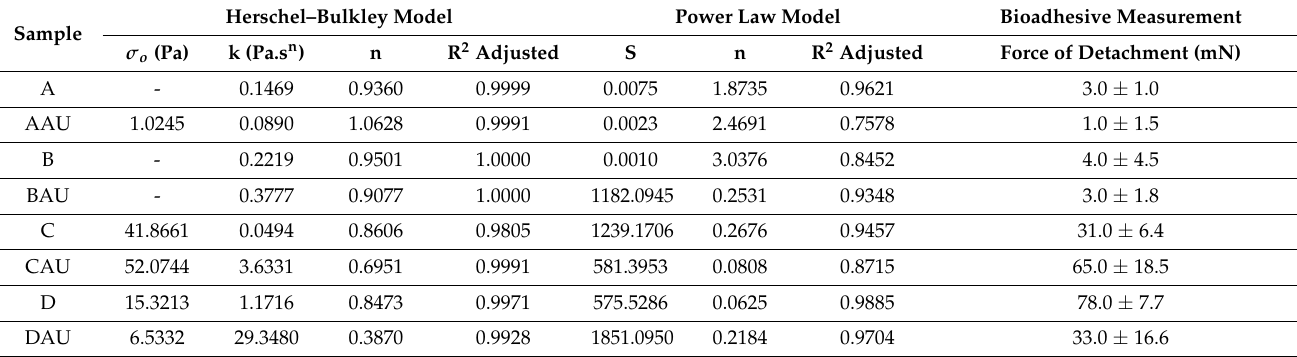
Figure 2. Rheograms obtained from unloaded and loaded formulations (( a , b ), respectively). Ascending curves are denoted by close symbols and descending curves are denoted by open symbols; oscillatory sweep obtained from unloaded and loaded formulations (( c , d ), respectively). G ′ and G ″ moduli are shown as closed and open symbols, respectively. A = formulation with OA%/S%/W% ratio of 40/50/10; B = formulation with OA%/S%/W% ratio of 30/50/20; C = formulation with OA%/S%/W% ratio of 20/50/30; D = formulation with OA%/S%/W% ratio of 10/50/40; AAU = formulation A loaded with AU; BAU = formulation B loaded with AU; CAU = formulation C loaded with AU; DAU = formulation Dloaded with AU. Table 1. Values of constants obtained by Herschel–Bulkley model and Power Law model from rheology assays and bioadhesive measurement. AAU = A with A; BAU = B with A; CAU = C with A; DAU = D with A.